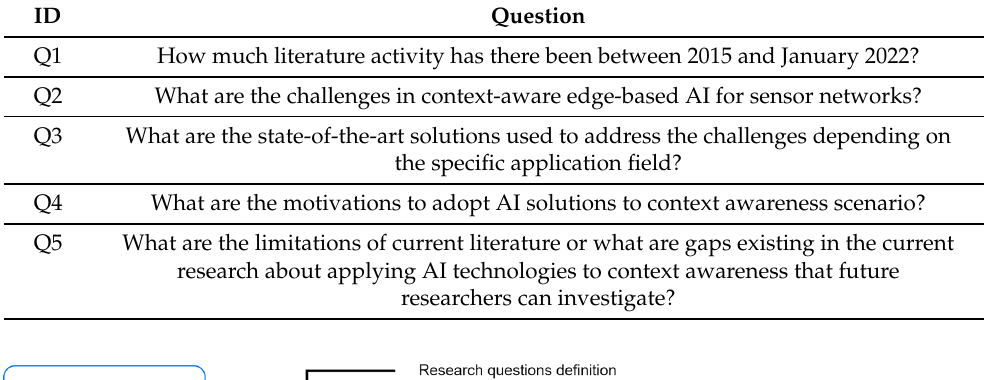
Table 2. Research questions (RQs).